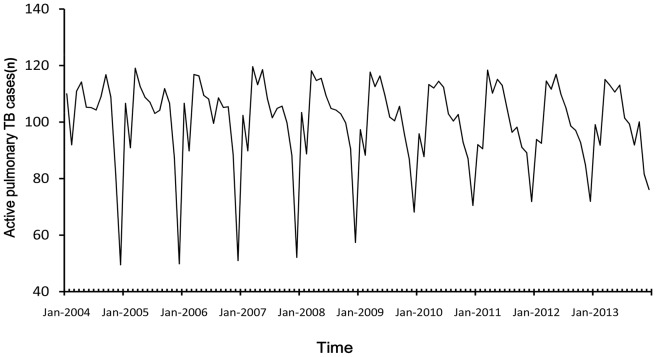
The seasonal component of time series.